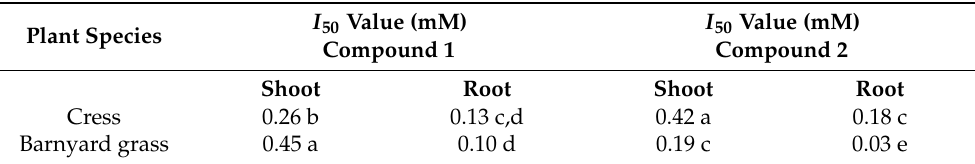
Table 2. I 50 values of the isolated compounds for the shoots and roots of barnyard grass and cress. Plant